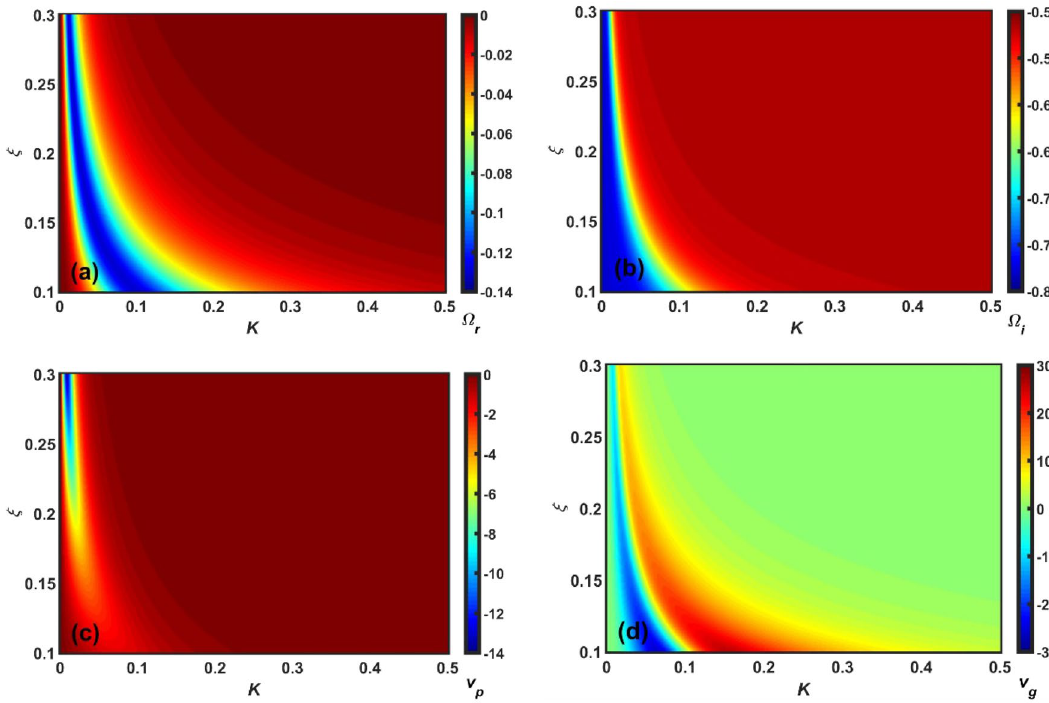
Figure 8. Same as Fig. 5, but showing the ξ -variation with a fixed ρ ∗ h